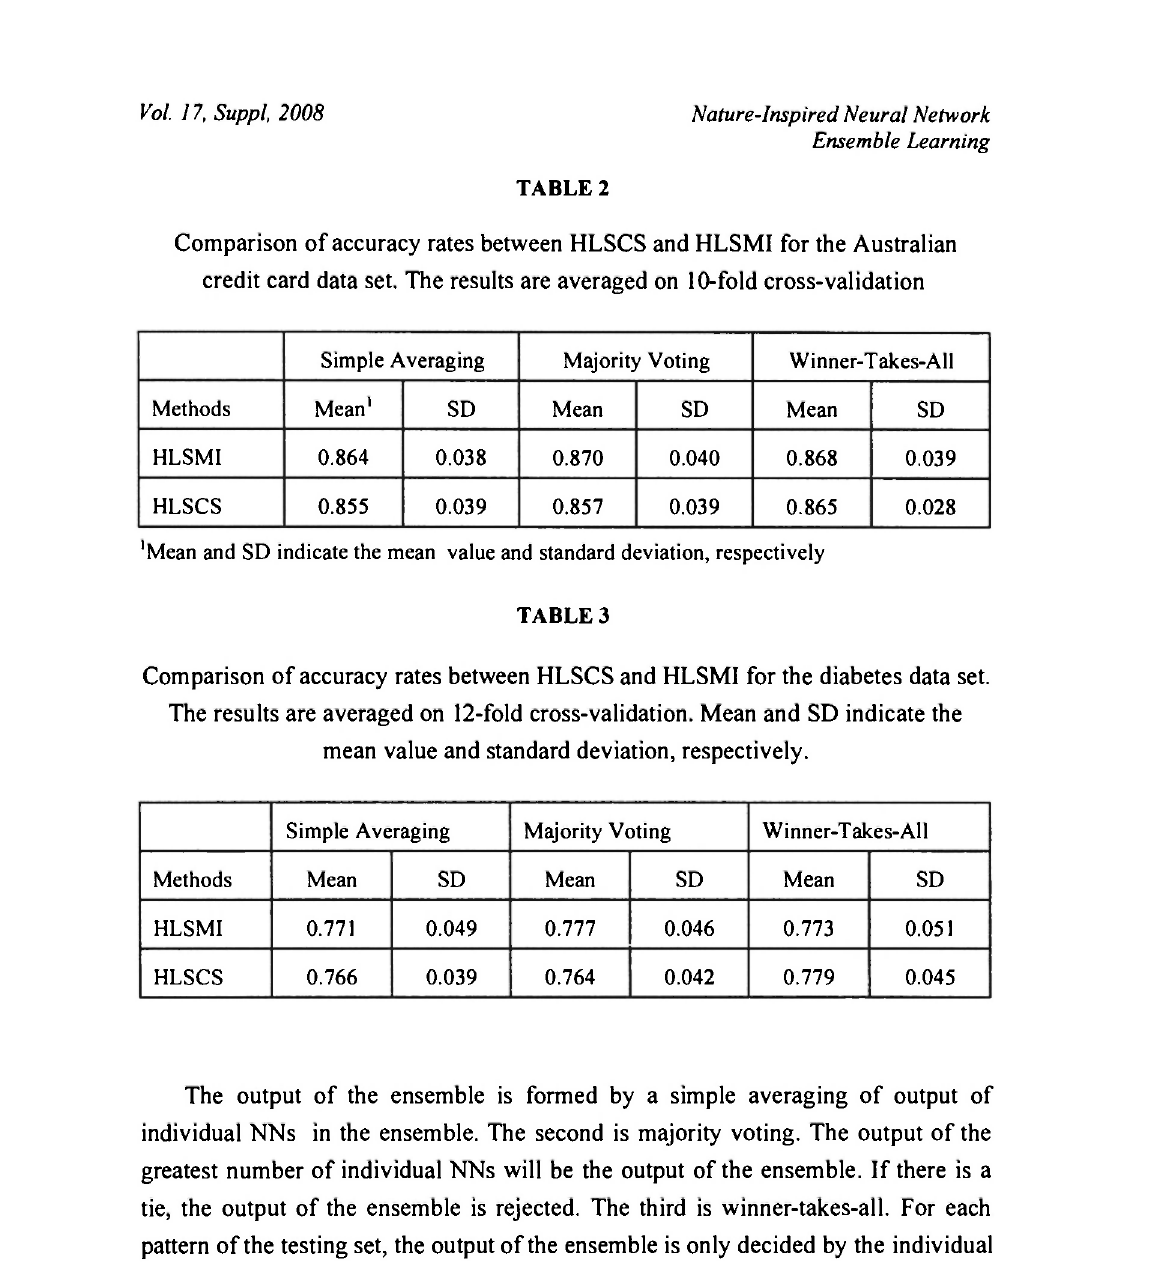
Comparison of accuracy rates between HLSCS and HLSMI for the Australian credit card data set. The results are averaged on 10-fold cross-validation